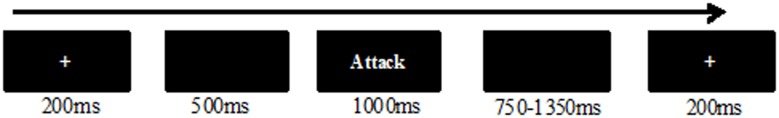
Lexical decision task trial procedure.